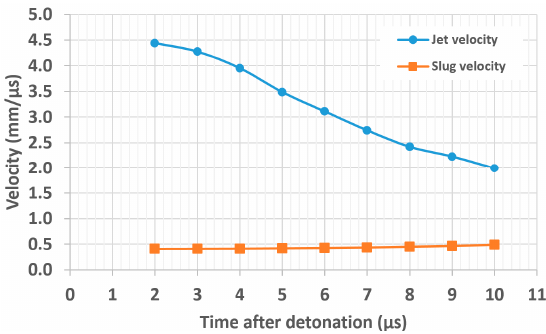
Figure 7. Jet and slug velocity of 2000 g/ft LSC [12].